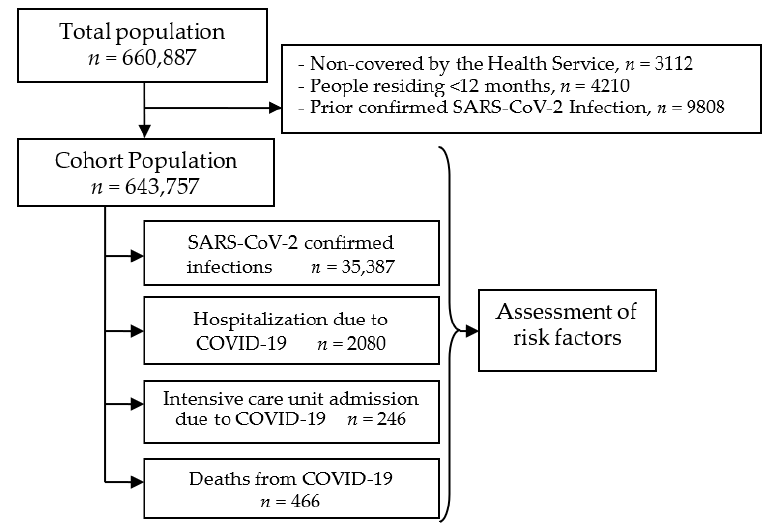
Figure 1. Scheme of the study. Table 1. Association between potential predictive factors and confirmed SARS-CoV-2 infection in the general population cohort.